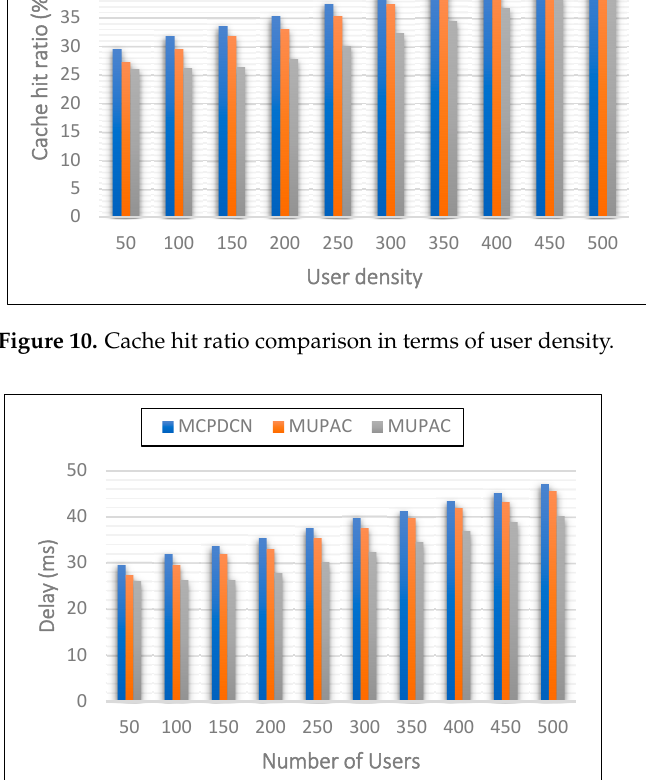
Figure 11. MUPAC vs LRU and LFU (delay) in terms of user density.